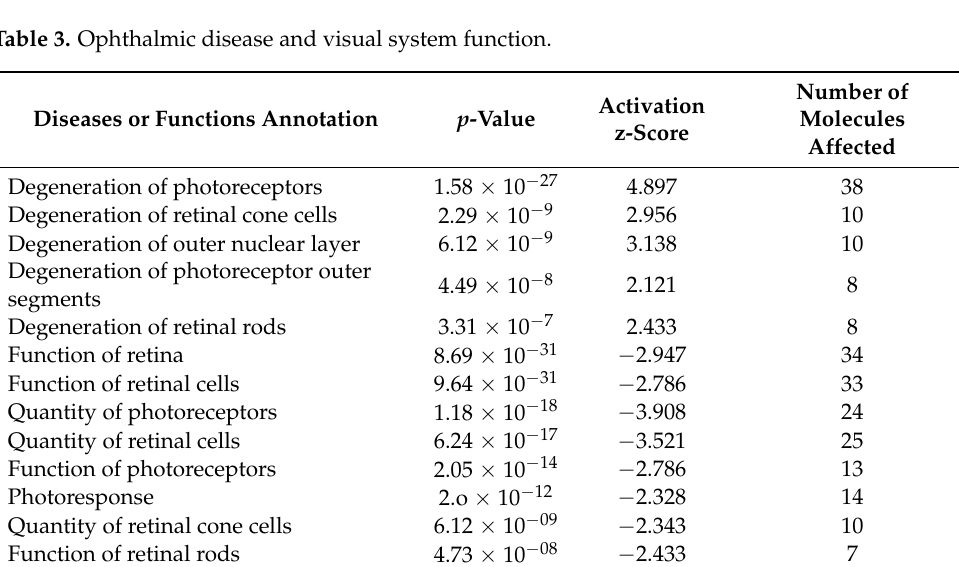
Table 3. Ophthalmic disease and visual system function.